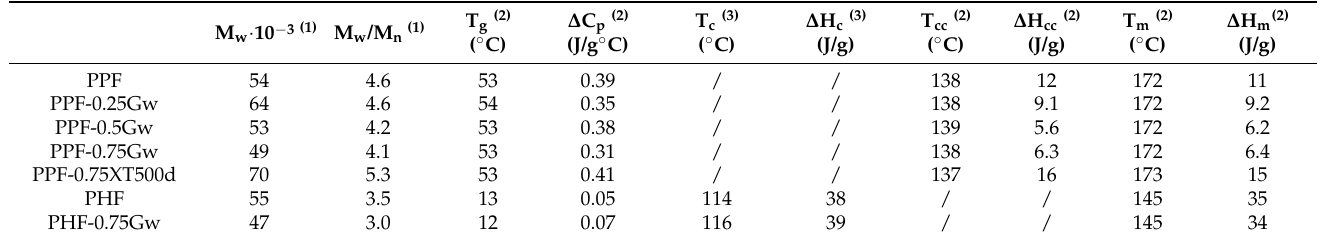
Table 1. Molecular characteristics and calorimetric data of PPF, PHF and their